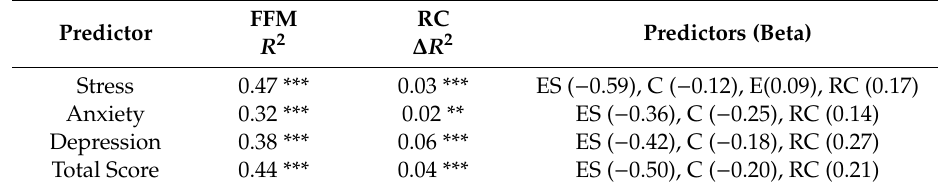
Table 3. Hierarchical multiple regression analyses examining the incremental validity of religious crisis scale in predicting the DASS scale